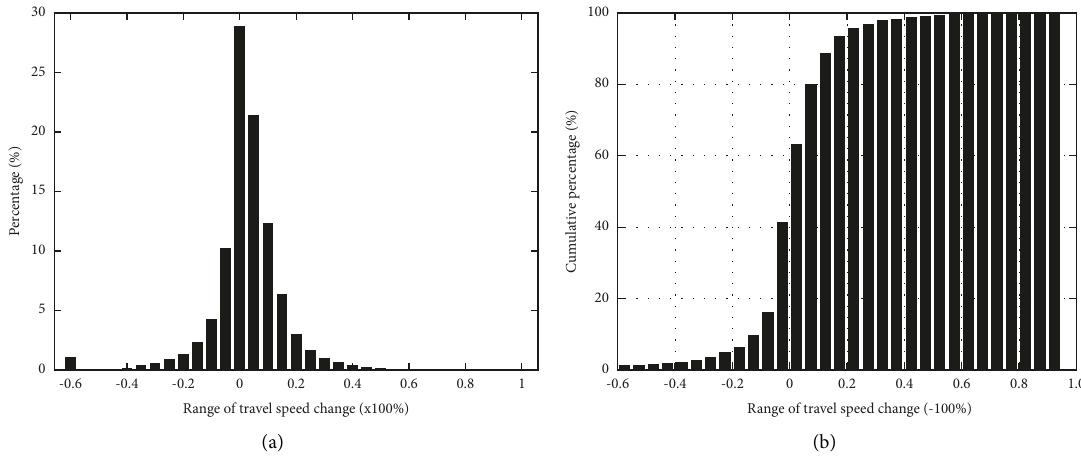
Figure 7: (Snowstorm) Frequency distribution of the magnitude of travel speed changes (a) and cumulative frequency distribution (b) by road section during the morning peak hour.